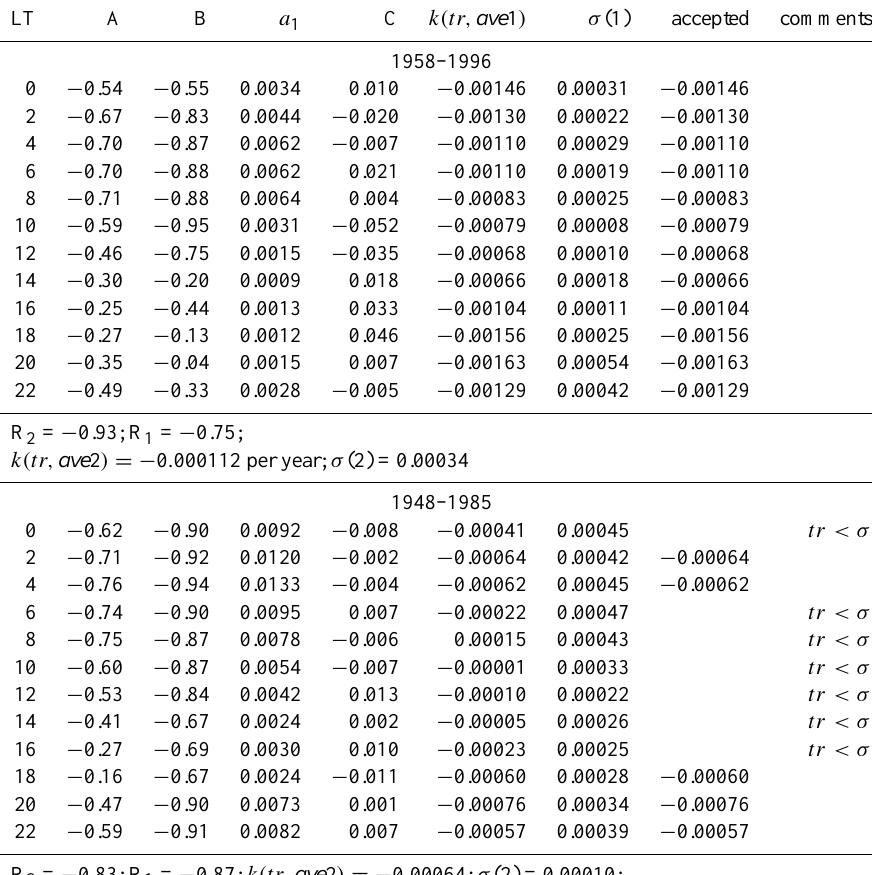
Table 4. Calculation of the trends for two periods for the Slough